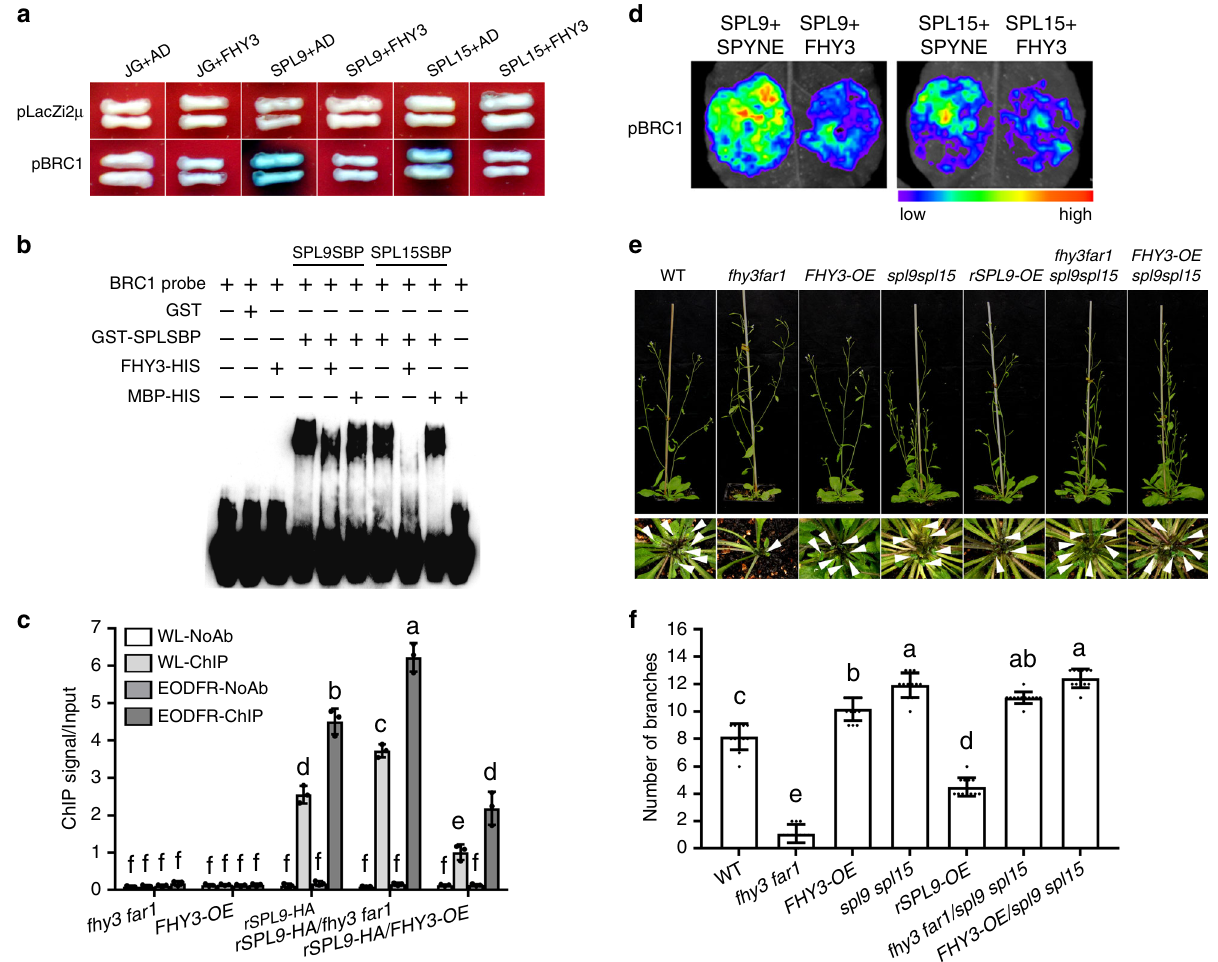
Fig. 4 FHY3 inhibits the binding and transactivation function of SPL9 and SPL15. a Yeast one-hybrid assay shows that FHY3 inhibits the binding of SPL9 and SPL15 to the BRC1 promoter. b EMSA assay shows that FHY3 inhibits the direct binding of SPL9SBP and SPL15SBP to the BRC1 promoter. MBP protein is used as the negative control. This assay was repeated for three times and similar results were obtained. c ChIP assay of BRC1 in axillary buds from 4-week- old 35S::rSPL9-HA transgenic plants in the WT, fhy3 far1 , or FHY3-OE backgrounds. Values given are mean ± SD ( n = 3). Letters indicate signi fi cant differences by two-sided LSD test ( p < 0.05). d Transient expression assay and quantitative analysis of luminescence intensity show that FHY3 inhibits the transactivation activity of both SPL9 and SPL15 on the LUC reporter gene driven by the BRC1 promoter. Representative images of N. benthamiana leaves 72 h after in fi ltration were shown. Five independent determinations were assessed. e Comparison of the rosette branch number of 4-week-old fhy3 far1 , spl9 spl15 , FHY3-OE , rSPL9-OE , and their higher order mutants grown under normal white light conditions. Arrow indicates the short rosette branches. f Quanti fi cation of the number of rosette branches of fhy3 far1 , spl9 spl15 , FHY3-OE , rSPL9-OE , and their higher order mutants grown under normal white light conditions. Values shown are mean ± SD ( n = 12). Letters indicate signi fi cant differences by two-sided LSD test ( p <